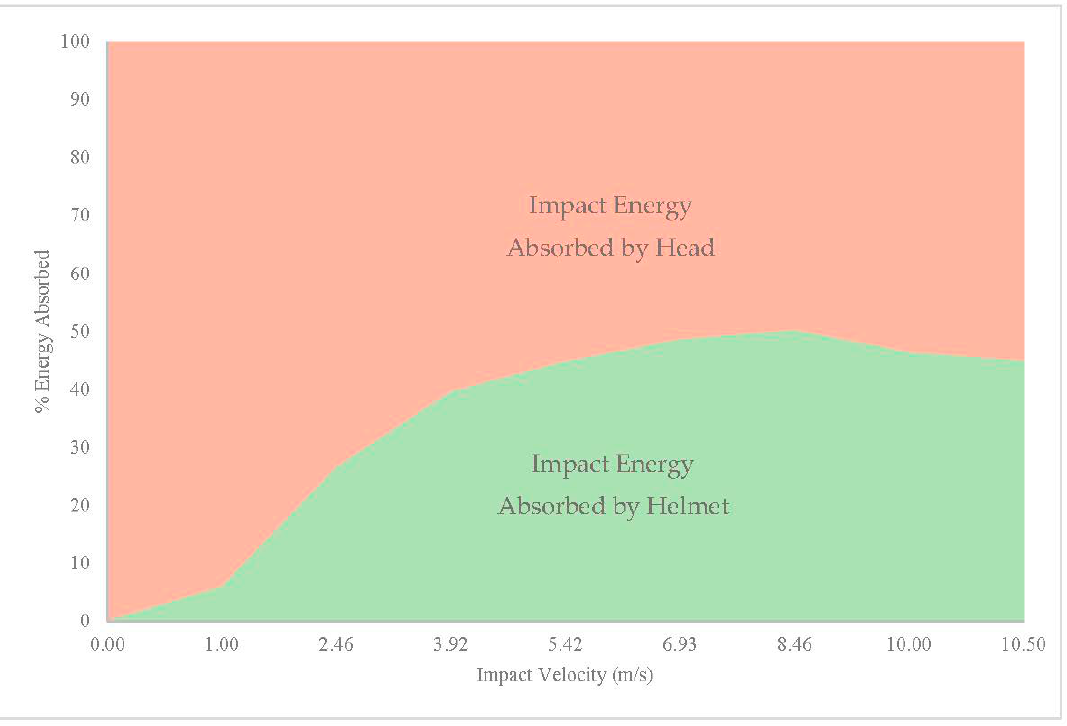
Figure 9. Energy absorbed by the Head and Helmet.